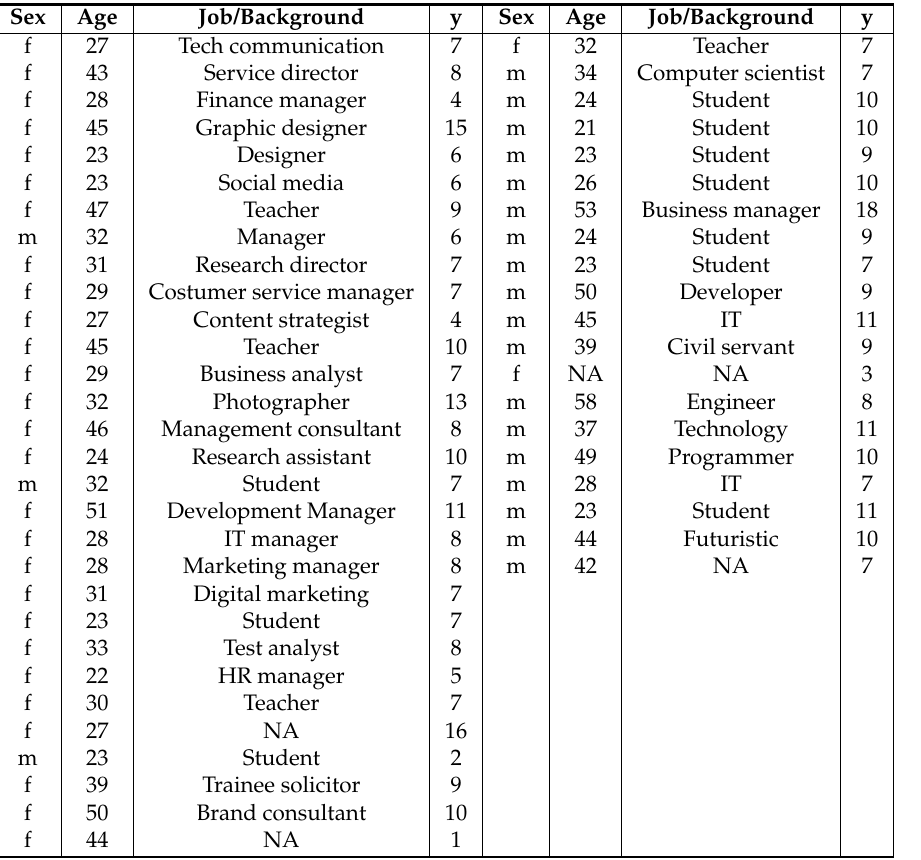
Table A1. Participants’ self-reported demographics; y indicates the years of owning a smartphone; left: Workshop 1 (2016), right: Workshop 2